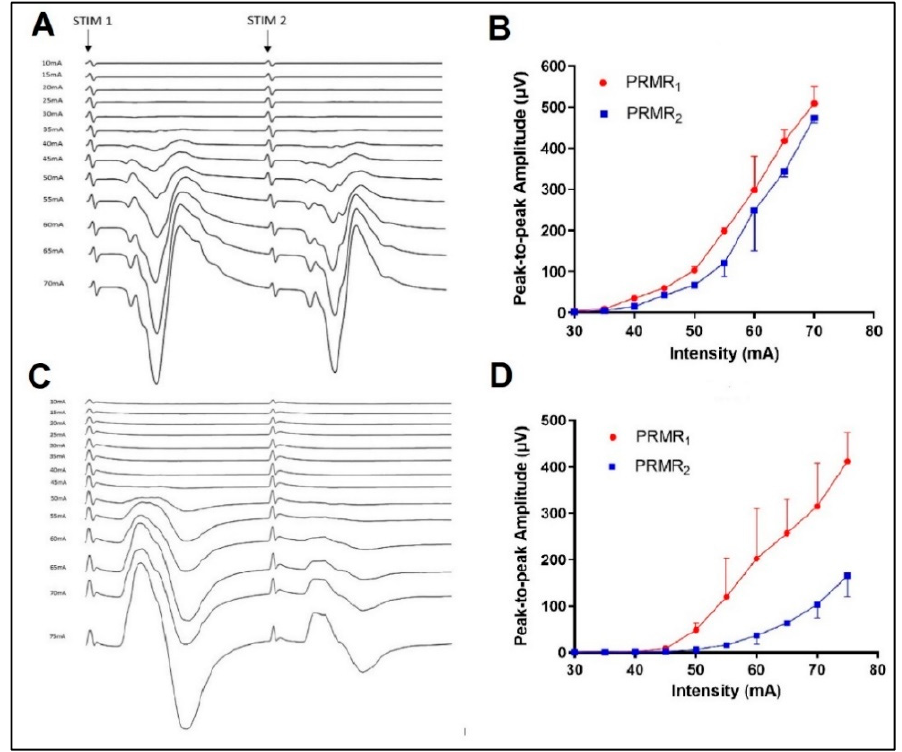
Figure 2. Incremental EMG traces (( A ) and ( C )) and corresponding intensity–response curves (( B ) and ( D )) of FCR muscle in two separate participants. Note the large variation in PRMR 2 response between individuals (( B ) vs. ( D )).